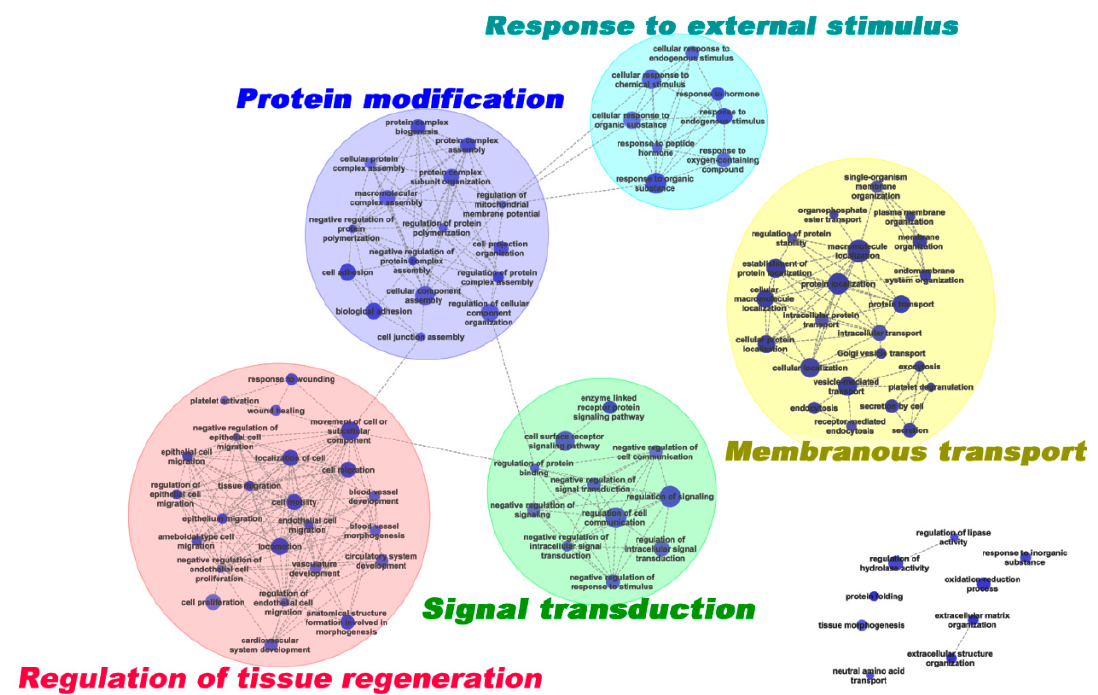
Figure 3. Network of enriched GO terms derived from DEPs. The enriched GO terms are organized as a weighted similar network, with nodes representing enriched GO terms (adj. p < 0.05) and edges representing the overlap score (coeffcient cutoff of 0.5), calculated from the number of proteins shared by two GO terms.